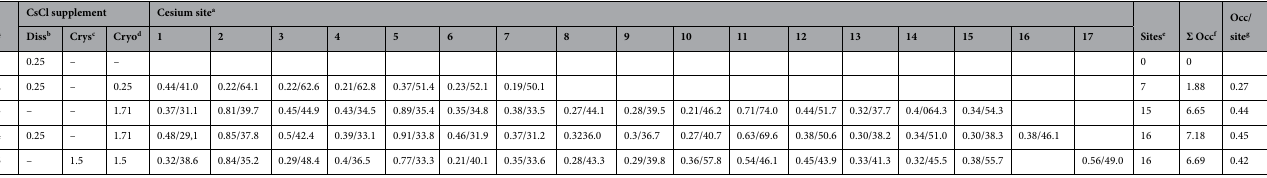
cesium was utilized instead of sodium in this step of the purification process (Fig. 5). Furthermore, the presence of CsCl in the crystallization solution did not impact crystallization as depicted in Fig. 6. Taken together, these results further support that CsCl may be highly compatible with purification and crystallization of macromol- ecules. The different approaches are summarised in Table 6. The final data collection and refinement statistics are provided in Table 7.